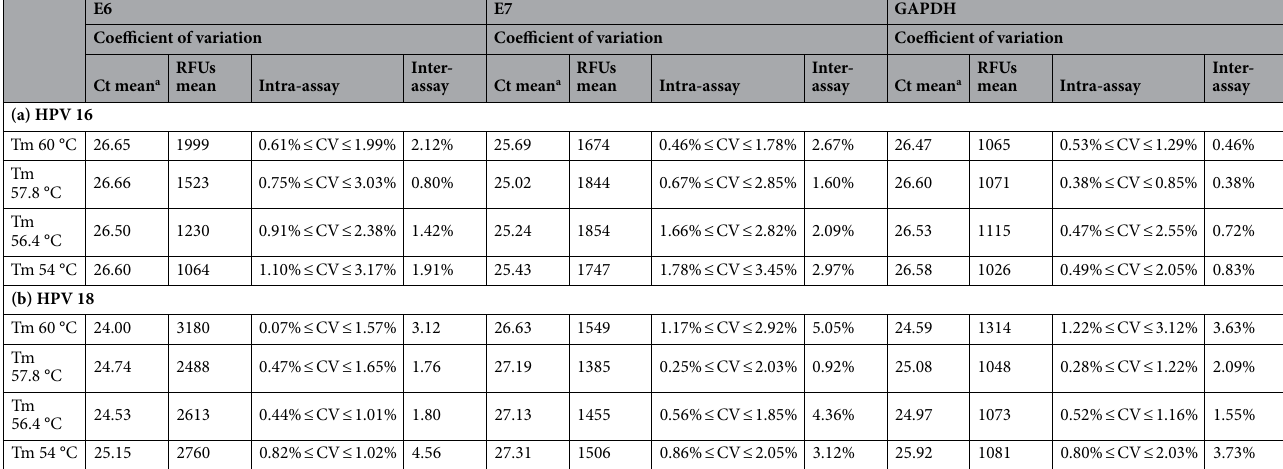
Table 3. Intra- and inter-assay reproducibility of HPV16 (a) and HPV18 (b) qPCR multiplexes for selected annealing temperatures. Ct cycle threshold, Cv coefficient of variation. a Mean of inter-assay Ct of technical triplicate.